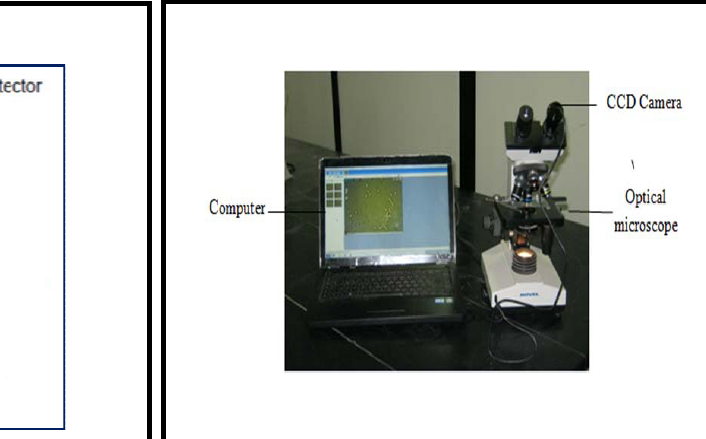
Fig. 2: The track's image in the field view and the track counting system.